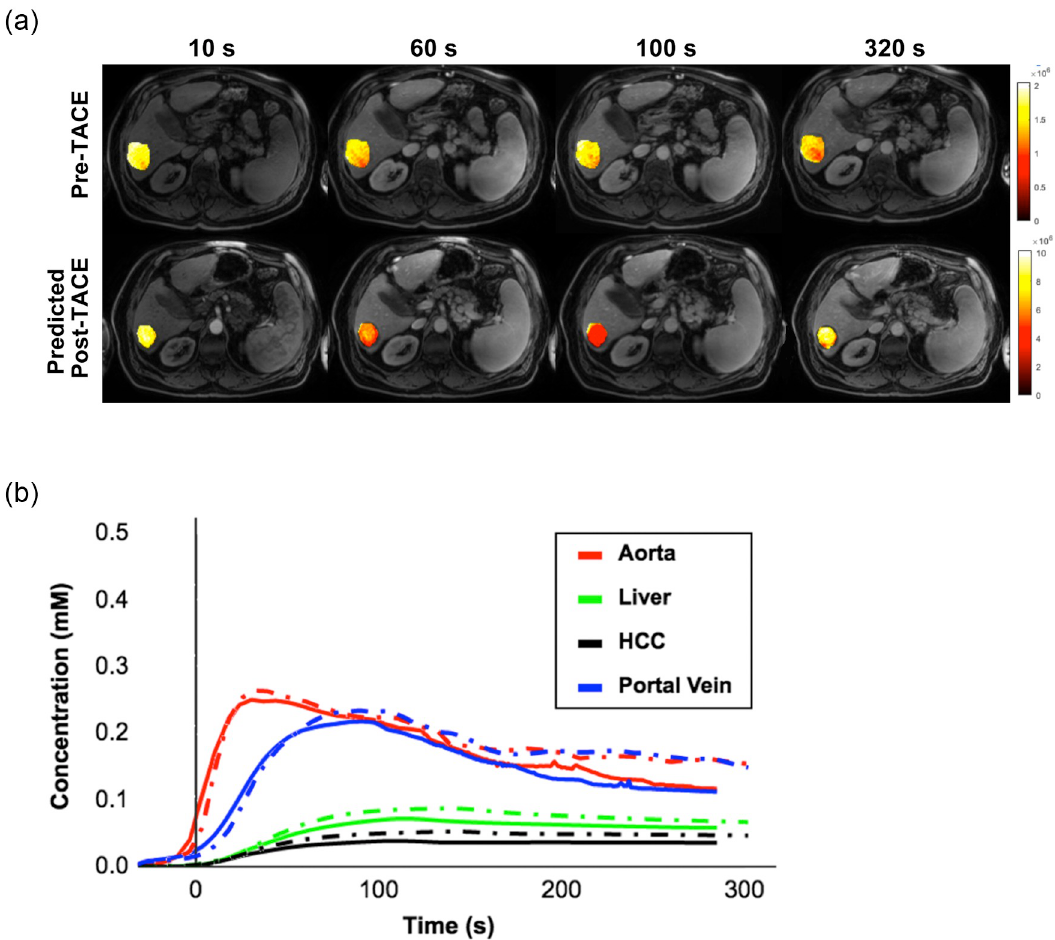
Fig 10. (a) Predicted tumor enhancement at sequential time points from the predicted post-TACE DCE-MRI images. Color maps indicate the changes within HCC tissue area. (b) Sample perfusion curves extracted from different liver regions (aorta, liver, HCC, portal vein), with the dashed lines indicating ground-truth post-TACE